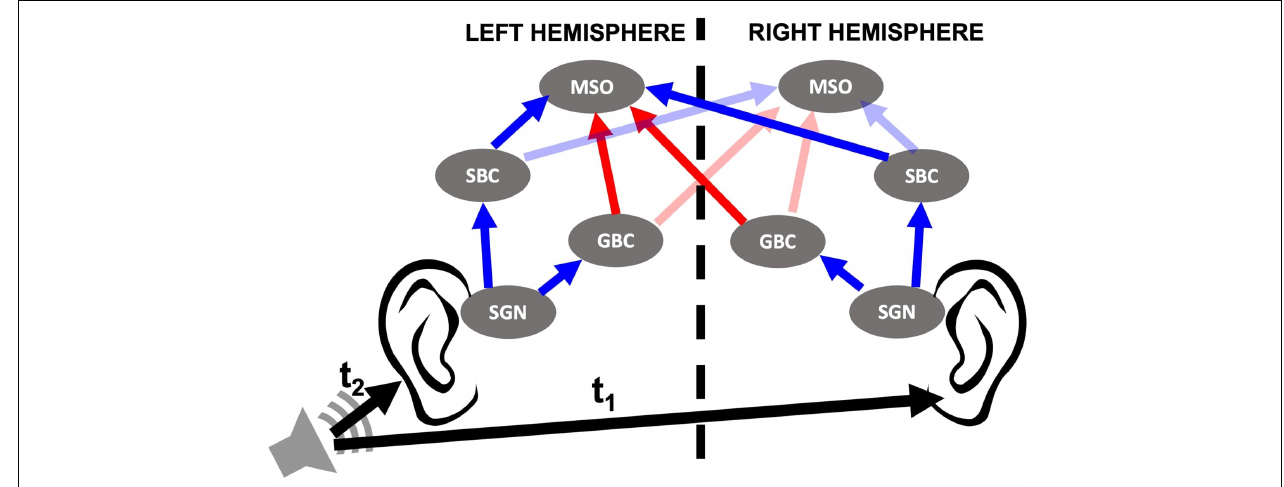
FIGURE 1 | Cochlear nucleus circuit model containing spiral ganglion neurons (SGNs), spherical bushy cells (SBCs), globular bushy cells (GBCs), and medial superior olives (MSOs) of both sides. Sound stimuli trigger release events at inner hair cell (IHC)-SGN synapses that stimulate SGN fibers as described in Budak et al. (2021). SGNs then relay the signal to the ipsilateral SBCs and GBCs in the cochlear nucleus. MSO cells in the brainstem receive excitatory (blue arrows) and inhibitory (red arrows) inputs from SBCs and GBCs, respectively, from both sides. LNTB and MNTB that relay input from ipsi- and contralateral GBCs, respectively, are omitted from the model and therefore not shown in the circuit. The horizontal location of the sound source is defined by interaural time difference (ITD), the difference in the arrival time of the sound to both ears (t1–t2). ITD > 0 when sound comes from left and ITD < 0 when sound comes from